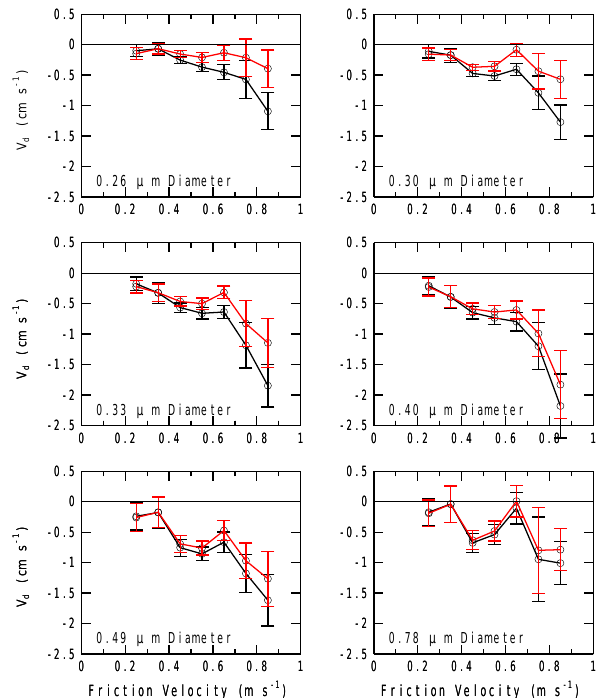
Fig. 6. Aerosol deposition velocities (daytime measured values, WPL corrected) versus friction velocity, both with (red) and with- out (black) the hygroscopic growth correction. Bars indicate ± one data standard error (negative V d is downward).